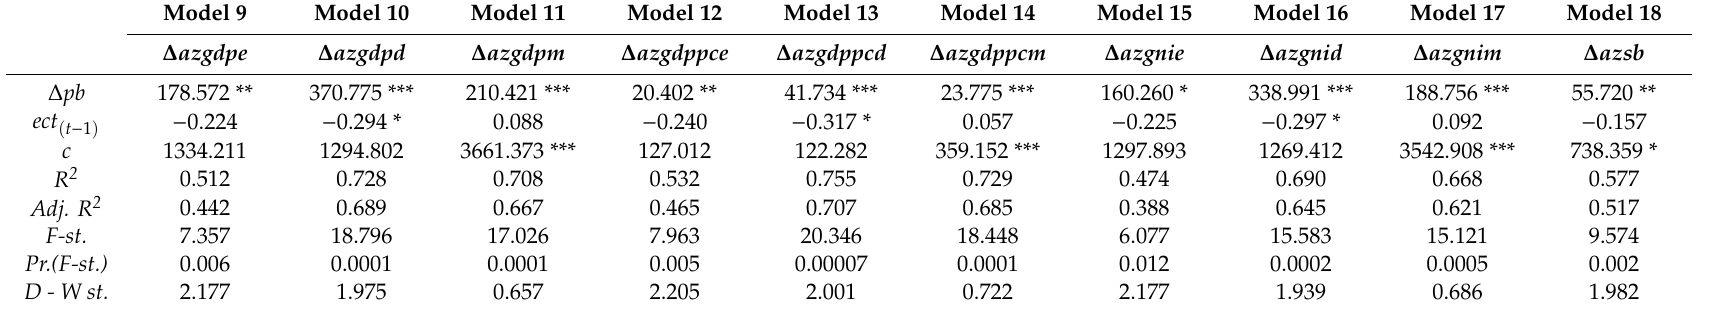
Table 3. The influence of oil price on macroeconomic indicators (Azerbaijan).